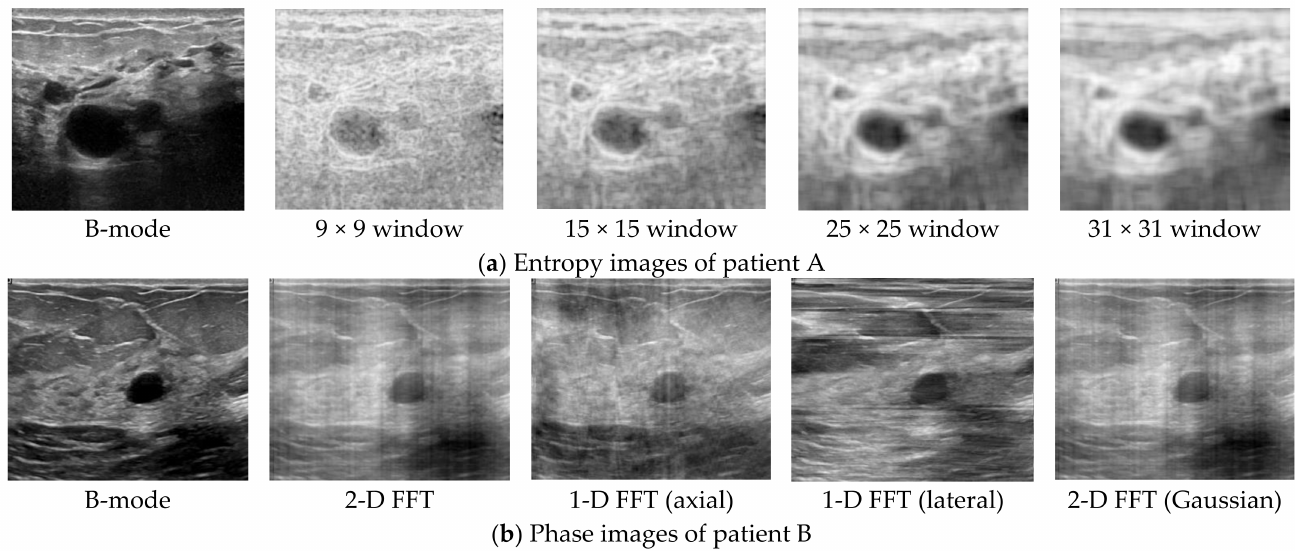
Figure 6. Examples of extended feature maps using different signal processing techniques; ( a ) entropy images, ( b ) phase